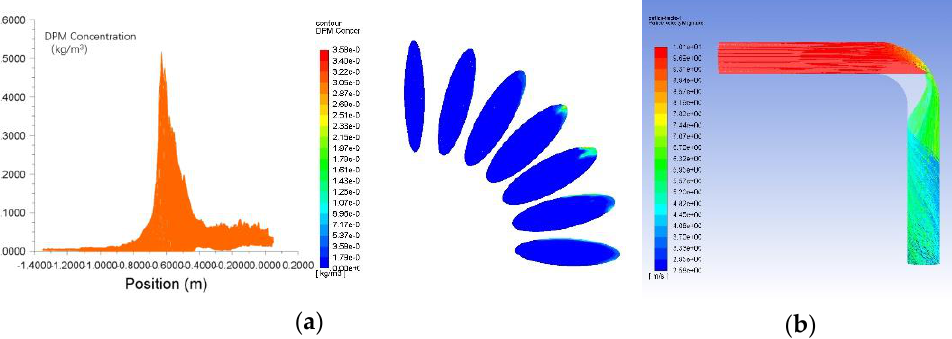
Figure 8. DPM concentration distribution and particle trajectories. ( a ) DPM concentration distribution; ( b ) Particle trajectories.